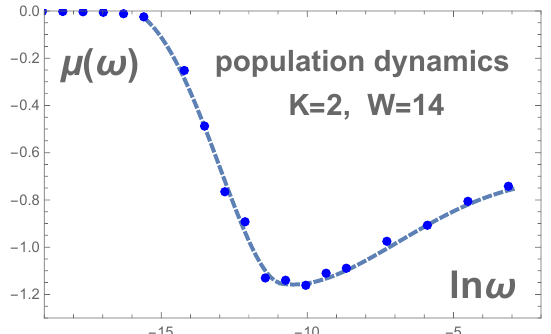
Figure 11: (Color online) µ ( ω ) , defined in Eq. (56) extracted from the population dynamics (PD) data on K ( ω ) presented in Fig.10 of Ref. [ 13 ] . The dashed line is merely a guide for eye. The position of the minimum µ to poor